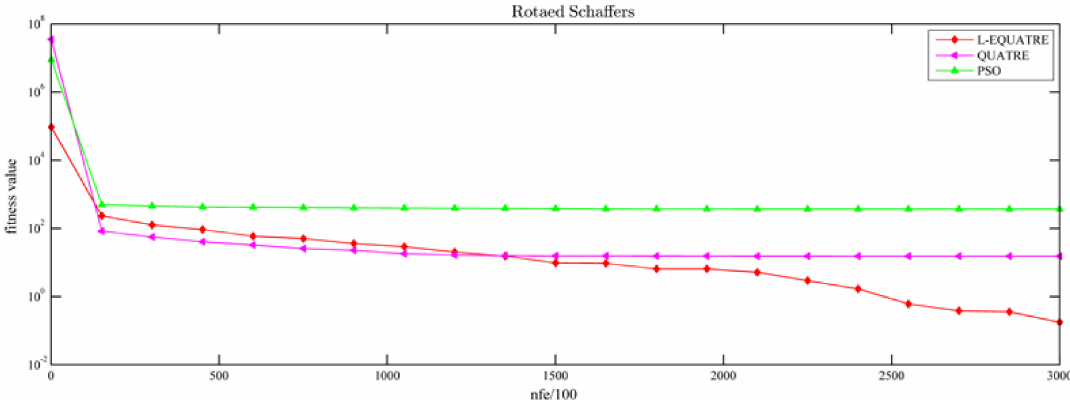
Figure 2. Rotated Schaffer’s F7 function.